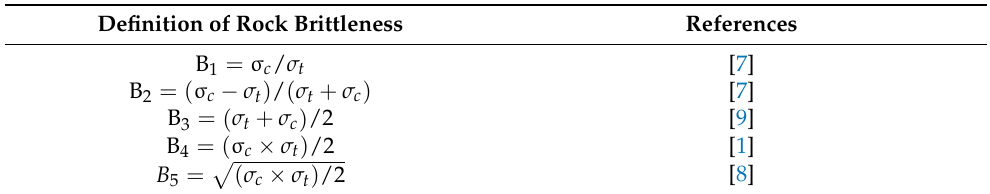
Table 1. Different definitions of rock brittleness based on rock strengths in previous studies (modified from